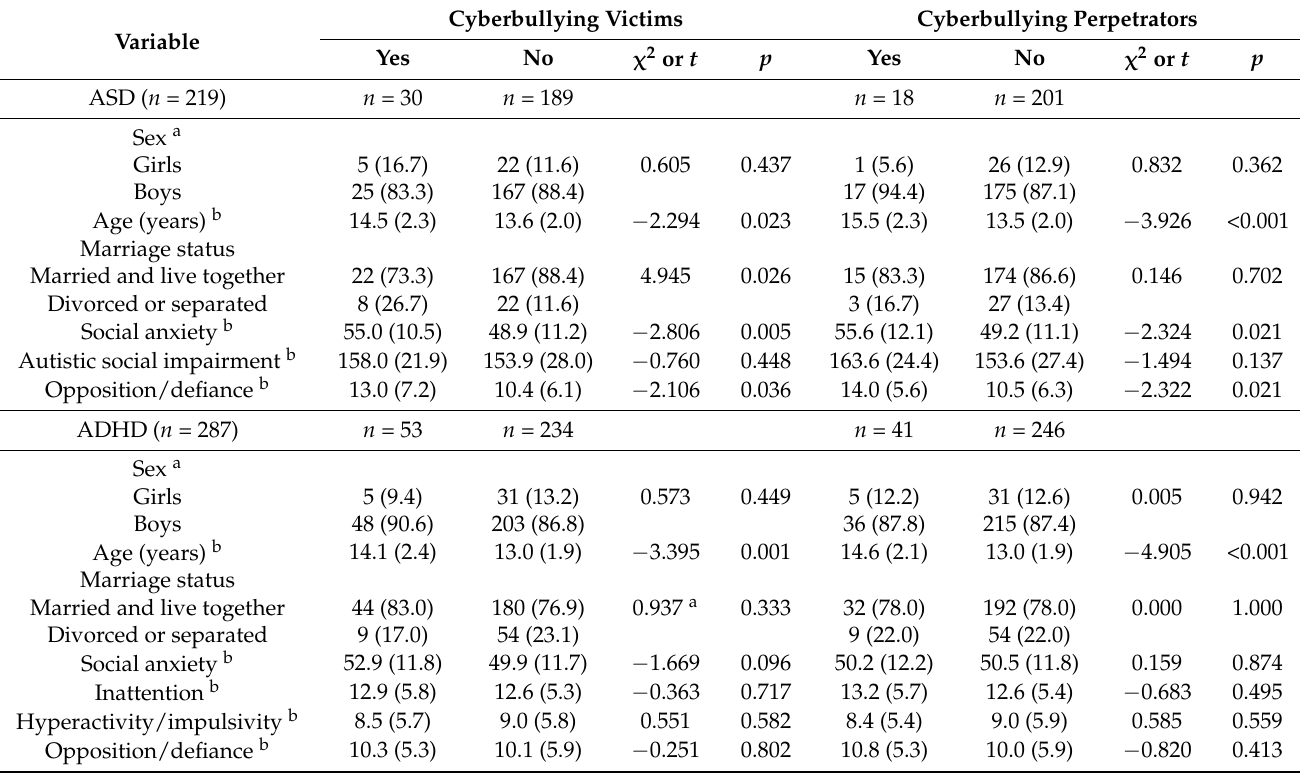
Table 2. Comparisons of Demographic Characteristics, Autistic Social Impairment, ADHD and Oppositional Defiant Symptoms, and Social Anxiety Between Adolescents Involved and Not Involved in Cyberbullying: Chi-squared and t